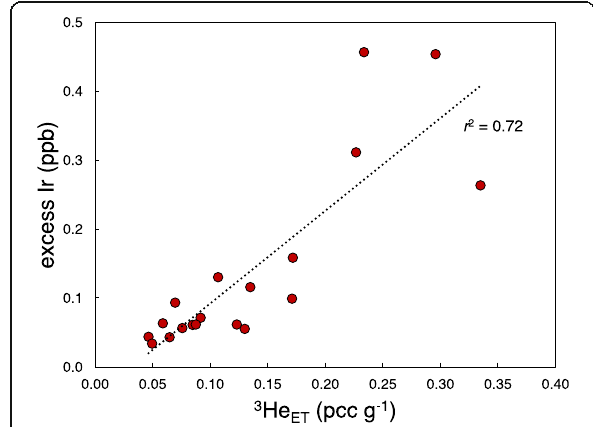
Fig. 5 Bivariate plot of extraterrestrial 3 He ( 3 He ET ) versus excess Ir in samples from the Waidani section. Dashed line represents linear regression between the two. See Table 1 for 3 He ET and Table 2 for excess Ir